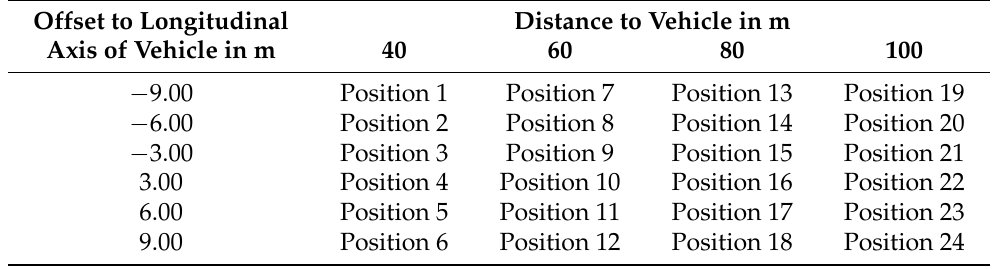
Table 2. Assignment of object positions to measurement grid points on the closed test site.